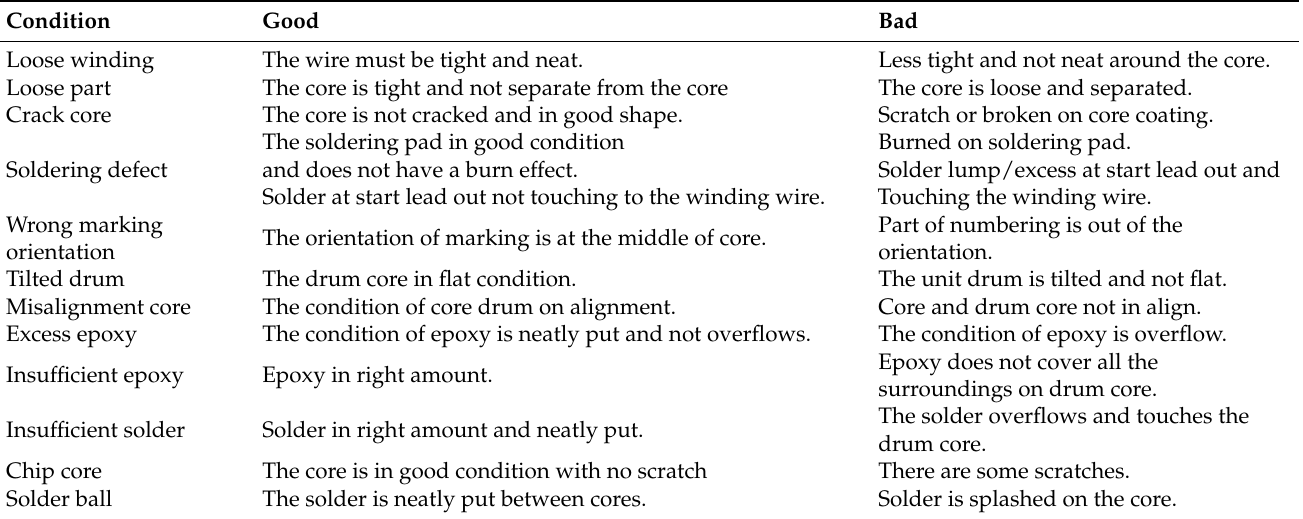
Table 1. Good and bad conditions of electronic component.